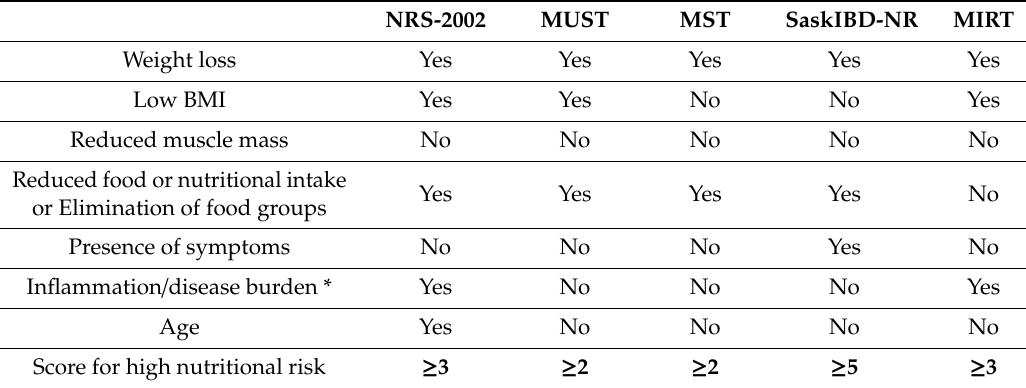
Table 1. Global Leadership Initiative in Malnutrition (GLIM) parameters included in nutritional screening tools used, and nutritional risk cut-o ff